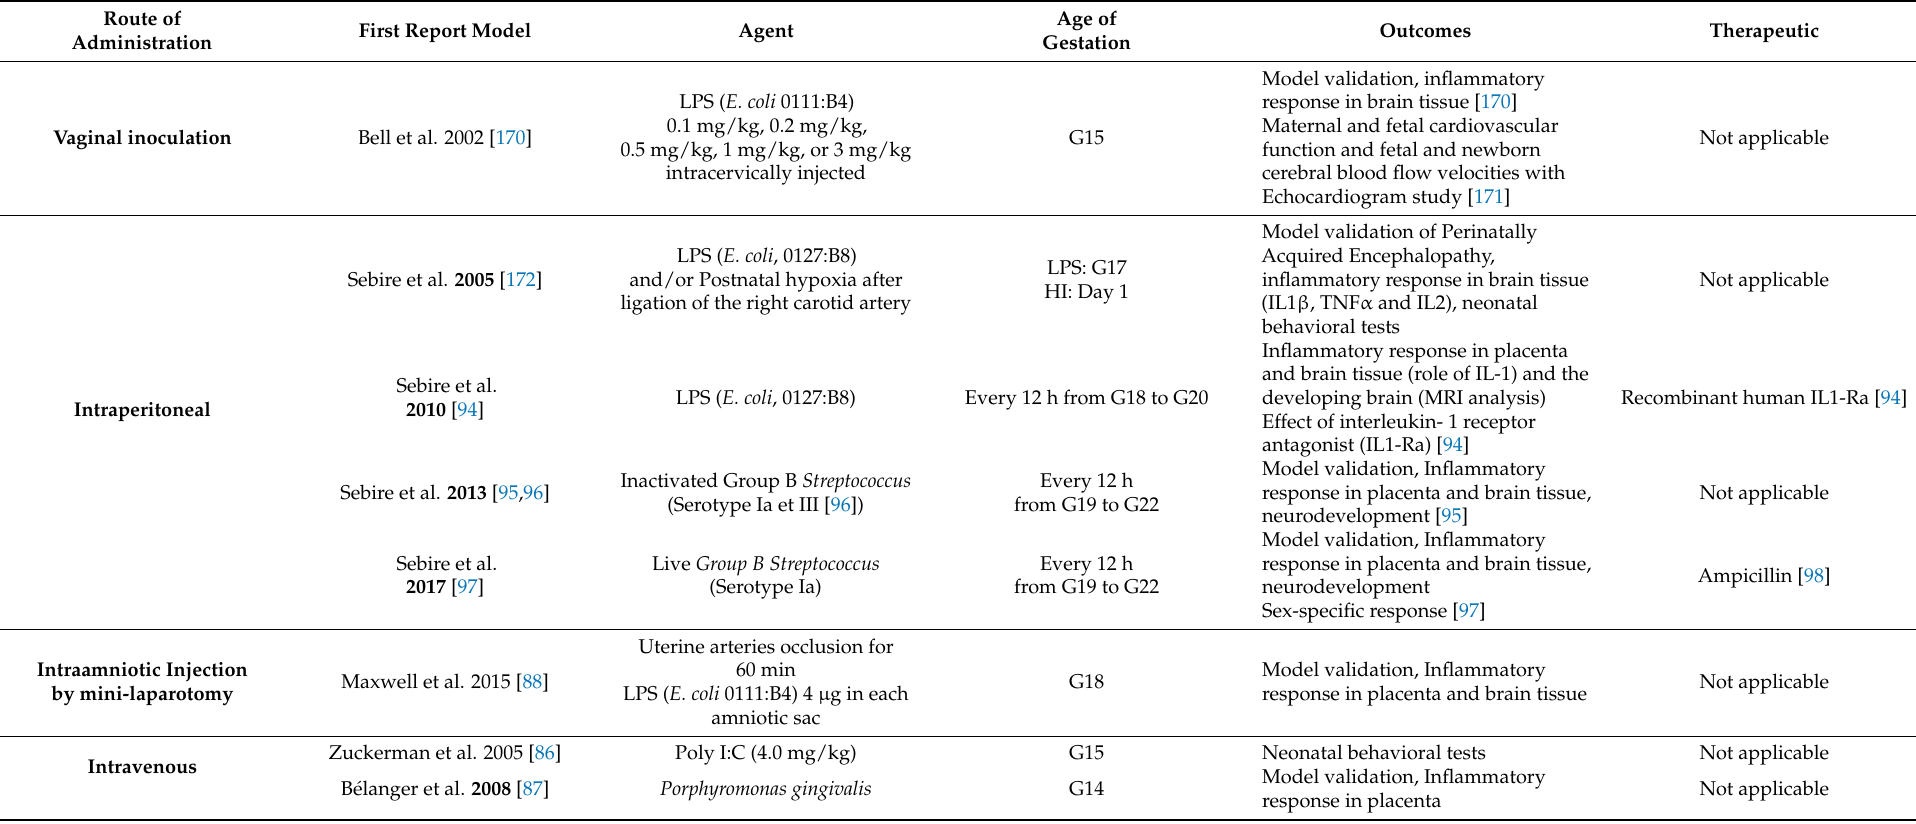
Table A2. Summary of rat models of acute